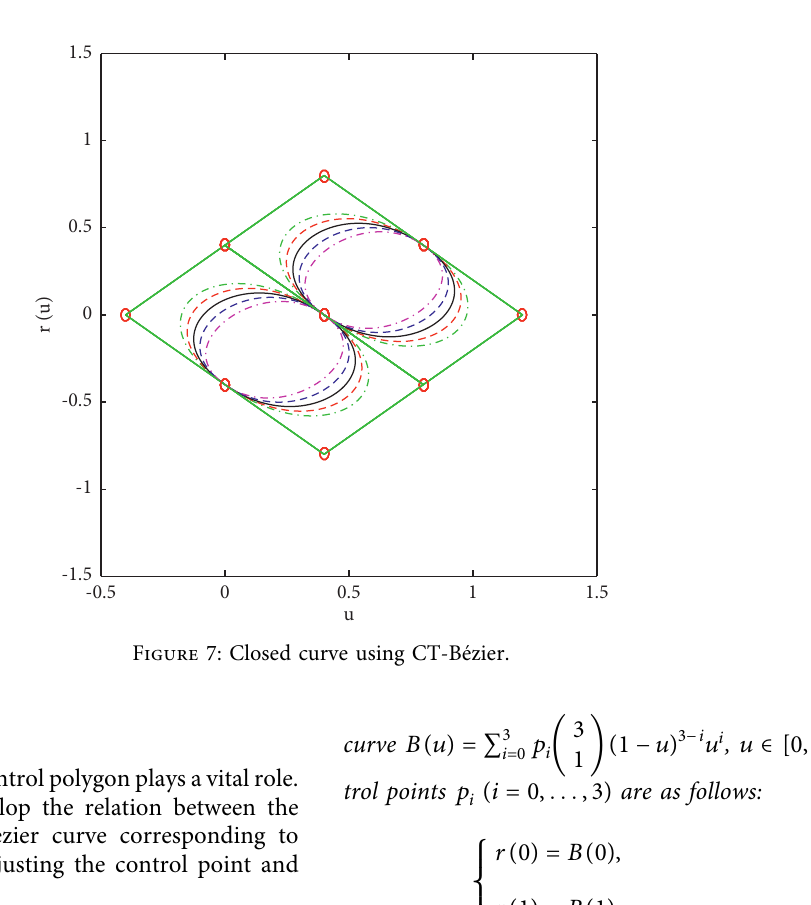
Figure 6: The effect of different values of m .